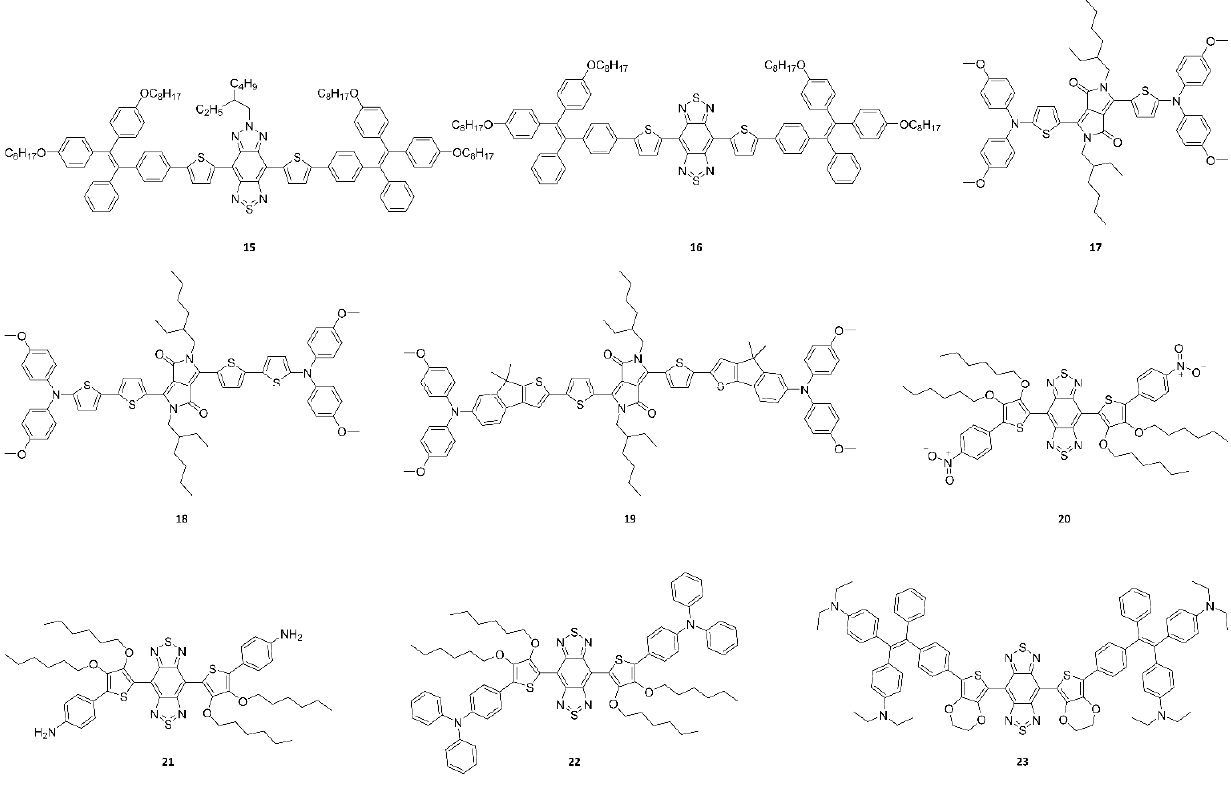
Figure 8. Scheme of chemical structures (probes 15 – 23 ) for bioimaging in the near-infrared range.